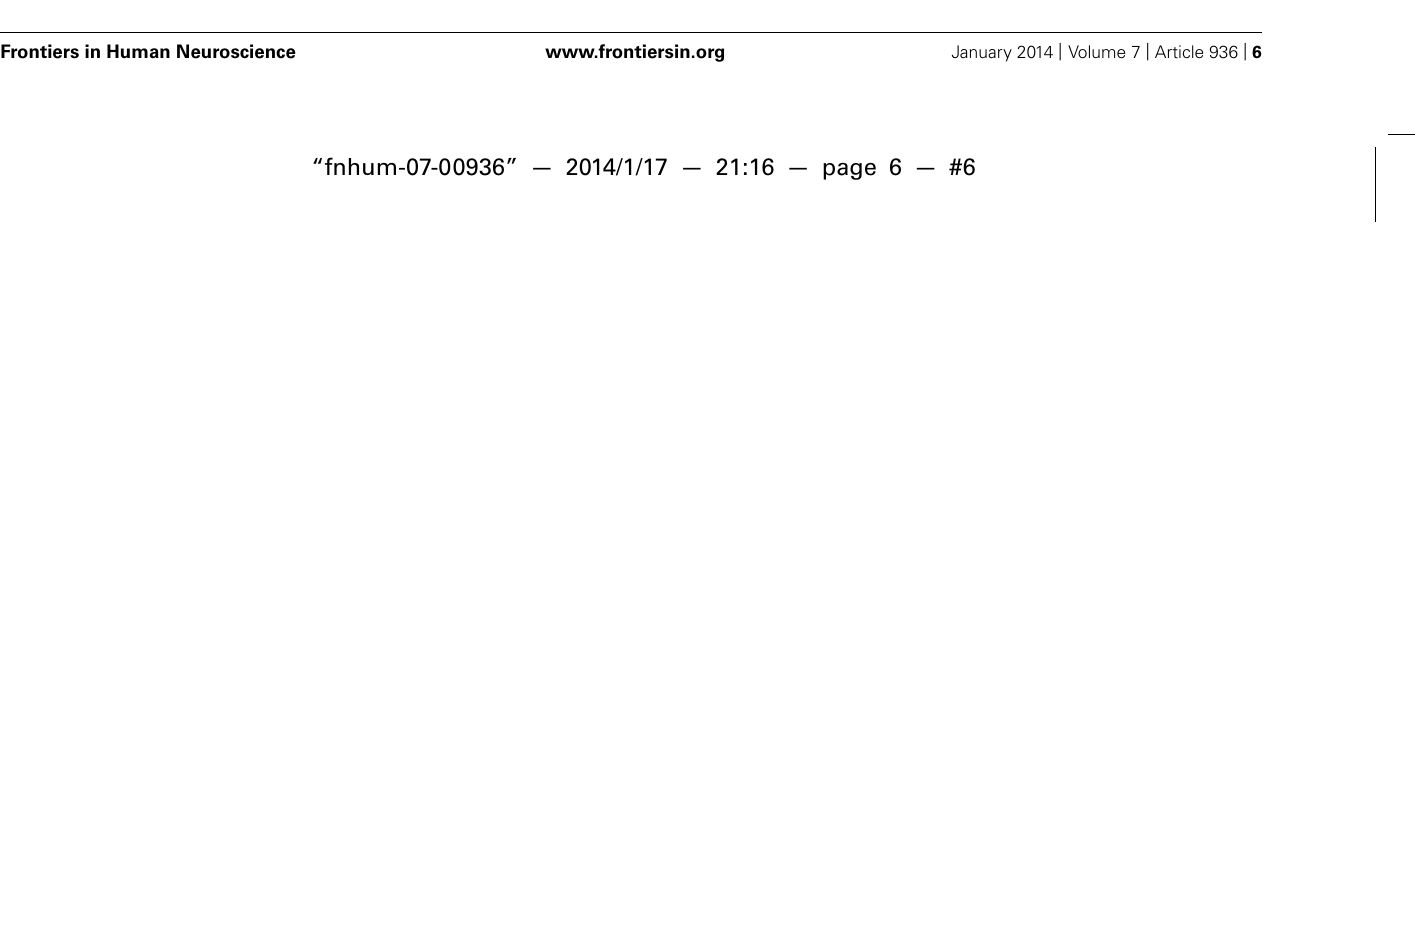
Figure 5 . Peak FRN amplitudes at electrode FCz were